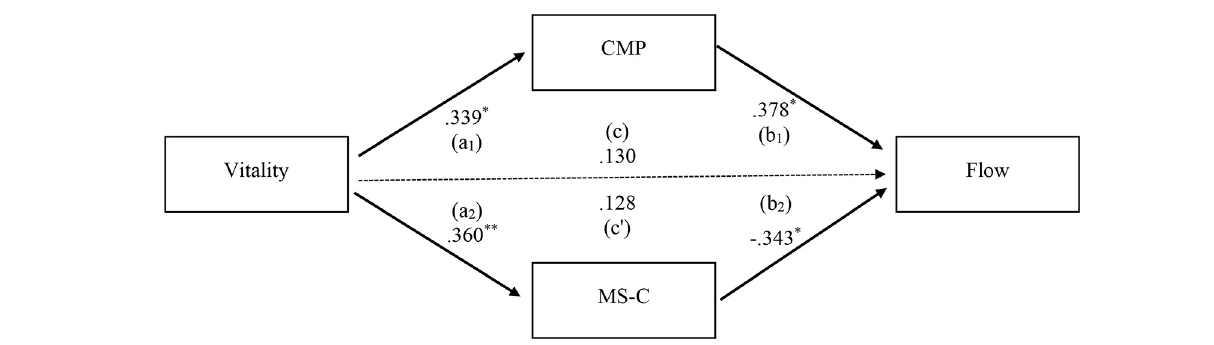
FIGURE 2 | Multiple mediation model for the association between vitality and flow. CMP, conscious motor processing; MSC, movement self-consciousness. Standardized coefficients (a 1 , a 2 , b 1 , b 2 ) from a bootstrap procedure are shown along the paths. The total effect of the antecedent variable (c) and the direct effect of the antecedent variable on the outcome variable (c’). Solid paths are significant ( p < 0.05) and dotted paths are non-significant ( p > 0.05). ** p < 0.01, * p < 0.05.